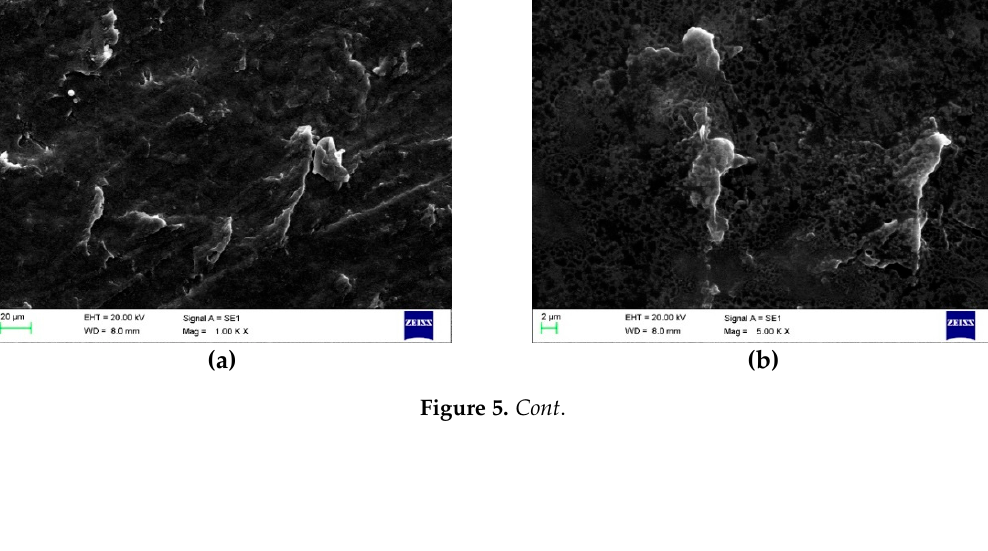
Figure 4. FE-SEM micrographs of film surfaces with a magnification of 1.00 K × ( a ) and 5.00 K × ( b ) and cross-sectional images with a magnification of 1.00 K × ( c ) and 10.00 K × ( d ) containing the highest concentration of sugar (14%) prepared according to the sol-gel-ma method (maleic anhydride and glycerol concentrations were 0.39% and 7%, respectively).